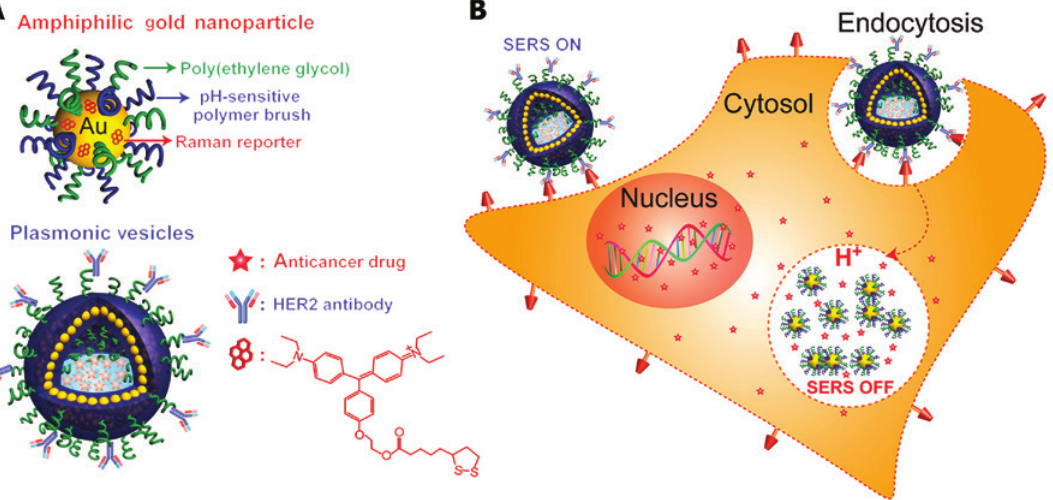
Figure 9: Schematic illustration of the amphiphilic gold nanoparticle assembled plasmonic vesicle for cancer cell targeting. Adapted from Song et al. J. Am. Chem. Soc. 2012 , 134 , 13458–13469. Copyright © 2014 American Chemical